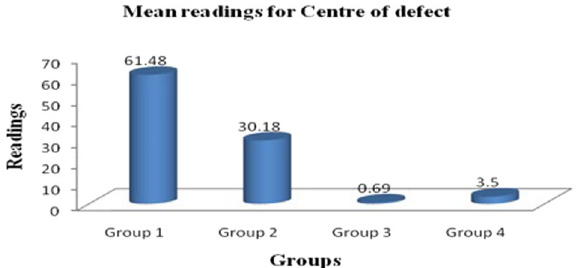
Fig. 11 Histogram shows the main reading for osteopontin stain at the centre of the